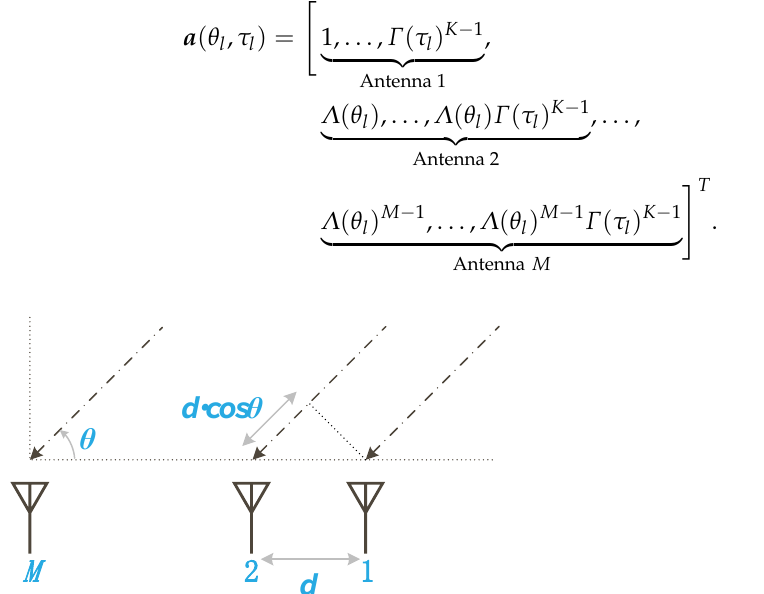
Figure 2. The uniform linear array consists of M antennas spaced at a distance d . Due to the additional distance dcos ( θ ) traveled in propagation, the signal is